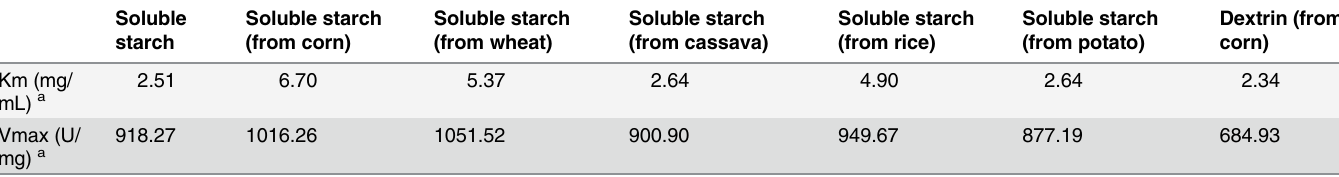
Table 2. Km and Vmax values of the TpAA to different soluble starches and dextrin. Soluble starch